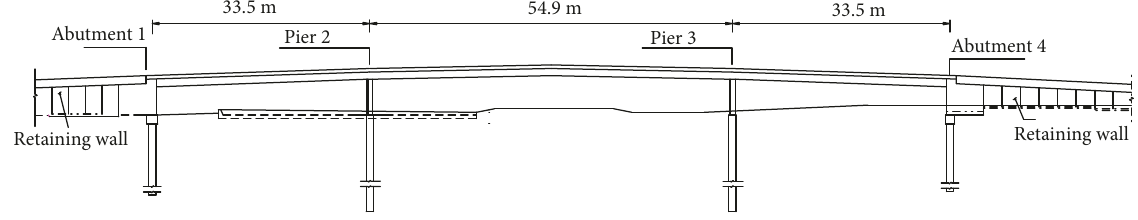
Figure 1: Demonstration project bridge